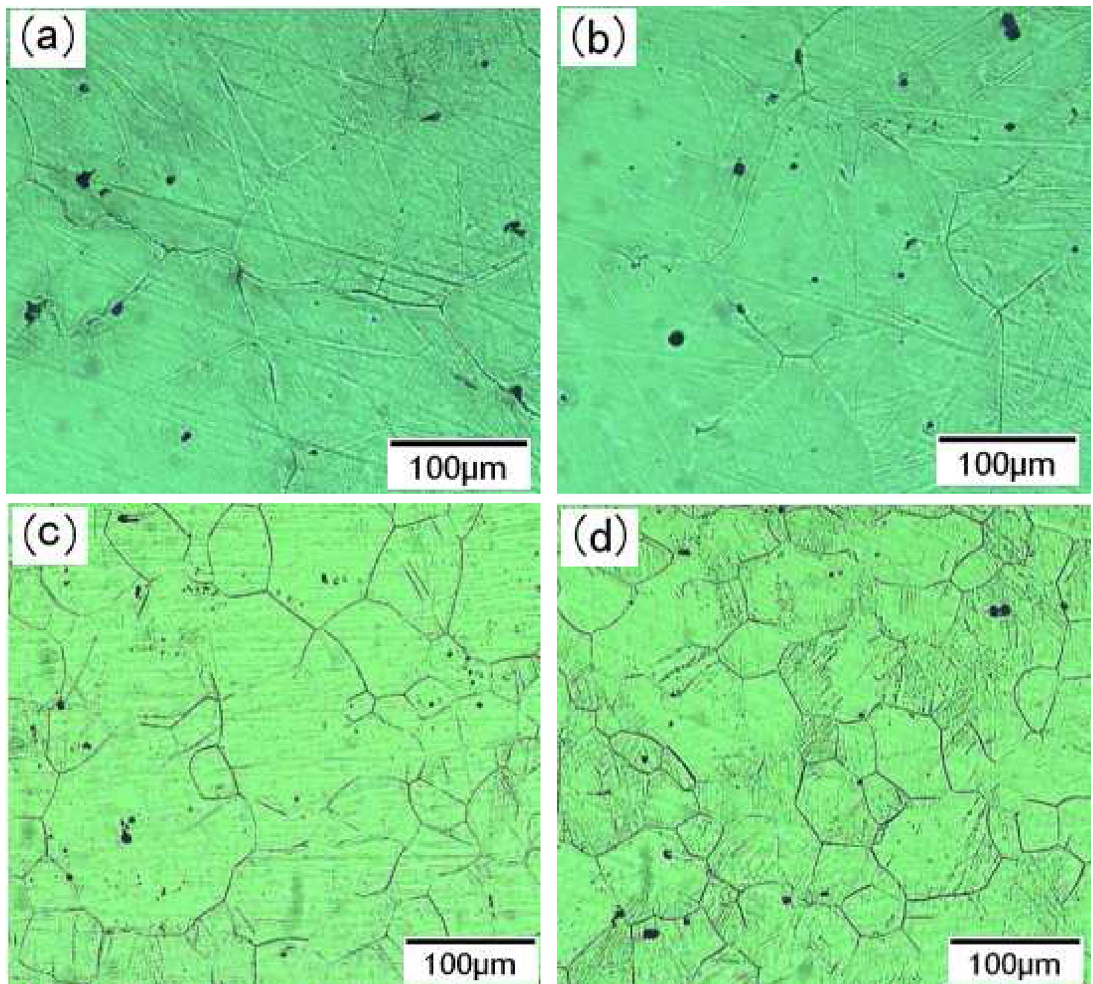
Figure 2. Optical micrographs of the as-cast alloys (a) Mg-1.5Zn-0.3Mn (1#), (b) Mg-2Zn-0.3Mn (2#), optical micrographs of the as- extruded alloys (c) Mg-1.5Zn-0.3Mn (1#), (d) Mg-2Zn-0.3Mn